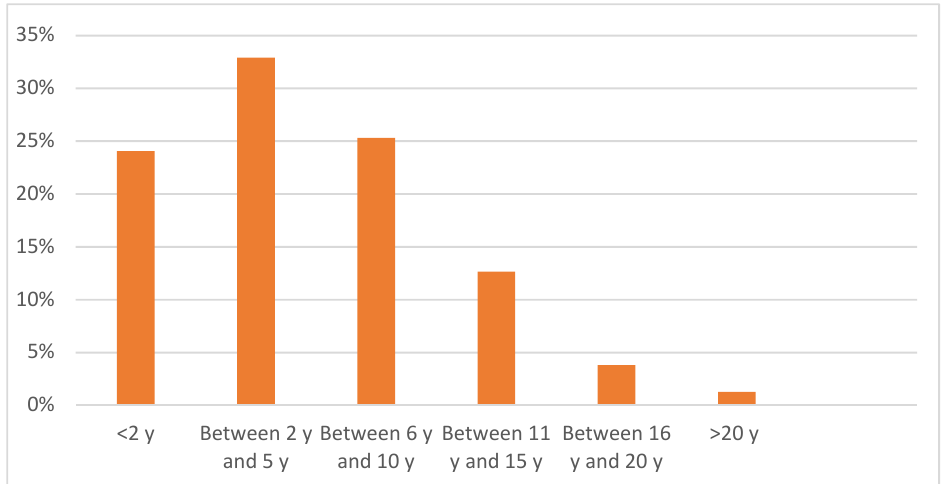
Figure 1. Years of experience of respondents in working in the pharma industry.